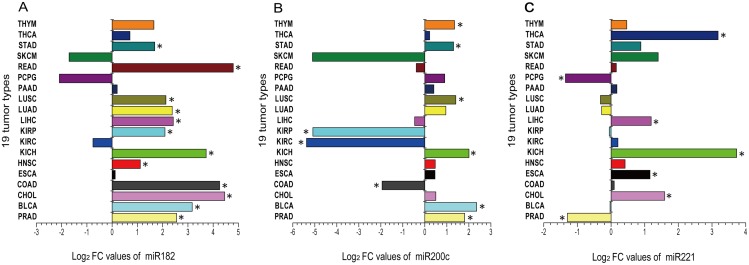
The log2 FC values of the three miRNAs in 19 cancer types.Fold change is the ratio of the median signals between cancer tissue and normal tissue. Abbreviations: FC, Fold change; PRAD, Prostate adenocarcinoma; BLCA, Bladder urothelial carcinoma; CHOL, Cholangiocarcinoma; COAD, Colon adenocarcinoma; ESCA, Esophageal carcinoma; HNSC, Head and neck squamous cell carcinoma; KICH, Kidney chromophobe; KIRC, Kidney renal clear cell carcinoma; KIRP, Kidney renal papillary cell carcinoma; LIHC, Liver hepatocellular carcinoma; LUAD, Lung adenocarcinoma; LUSC, Lung squamous cell carcinoma; PCPG, Pheochromocytoma and paraganglioma; READ, Rectal adenocarcinoma; STAD, Stomach adenocarcinoma; THCA, Thyroid carcinoma; THYM, Thymoma; PAAD, Pancreatic adenocarcinoma; and SKCM, Skin cutaneous melanoma. * The indicated miRNA expressed differentially in a cancer.